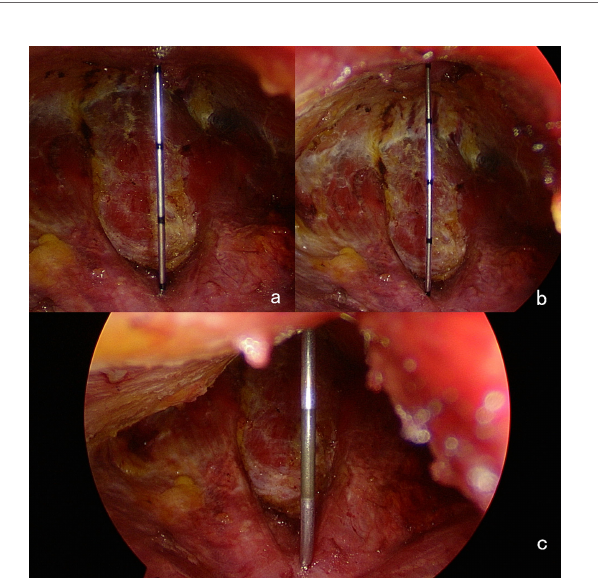
FIGURE 6 | (A) Measuring the height of the subcutaneous space before the elastic suspension. (B) The height of the subcutaneous space is increased by about 1 cm after elastic suspension. (C) There is still suf fi cient fi eld of view and operating space under vacuum aspiration. When the vacuum aspiration is performed during the procedure, the spring component of the elastic lifting cavity building system is stretched and extended. The hook and the skin fl ap are compressed downward to adapt to the negative pressure in the cavity. At this time, the cavity space is not completely collapsed, and it can maintain a suf fi cient fi eld of view and operating space. When the vacuum aspiration ends, the spring component quickly shrinks and retracts to restore the space to its initial